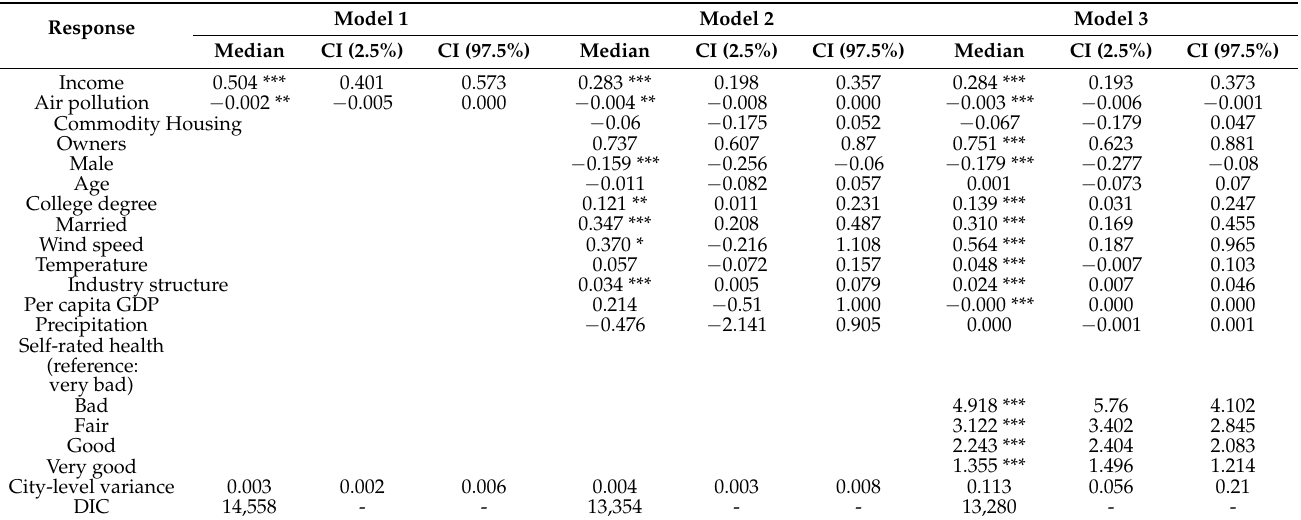
Table 2. Model estimation results from multi-level ordinal response